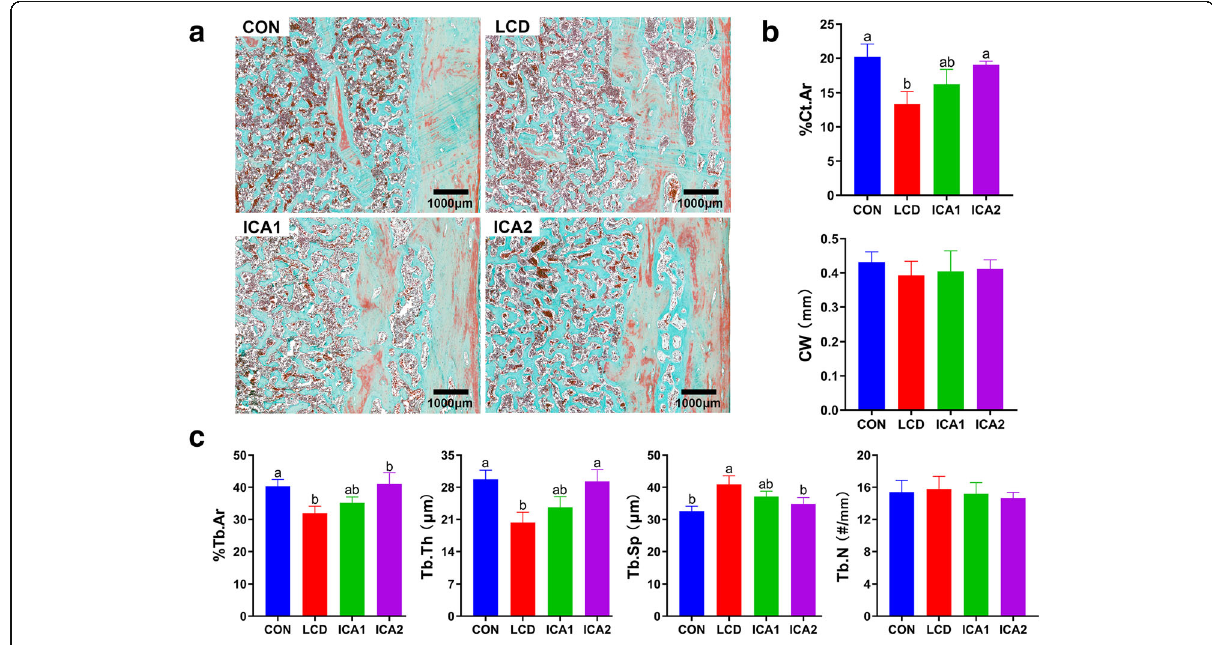
Fig. 2 Effects of ICA supplementation on microstructure of tibial bone tissues. a Representative images of Goldner ’ s trichrome staining (magnification, 10×). b Effects of ICA on cortical bone histomorphometry parameters. c Effects of ICA on trabecular bone histomorphometry parameters. CON, basal diet. LCD, low calcium diet. ICA, icariin. ICA1, low calcium diet supplied with 0.5 g/kg ICA. ICA2, low calcium diet supplied with 2.0 g/kg ICA. Ct. Ar, cortical area ratio. CW, cortical width. Tb. Ar, percent trabecular area. Tb. Th, trabecular thickness. Tb. Sp, trabecular separation. Tb. N, trabecular number. Data are presented as the mean ± SD ( n = 6). Means in each column with different alphabetic letters are significantly ( P < 0.05)